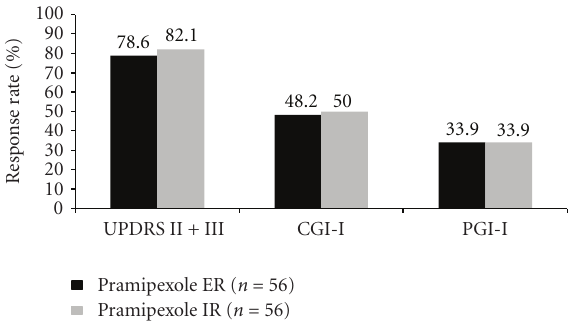
Figure 5: Response rates of pramipexole IR versus pramipexole ER. Comparison of the e ffi cacy parameters UPDRS II + II, CGI-I and PGI at study endpoint (week 12, FAS)